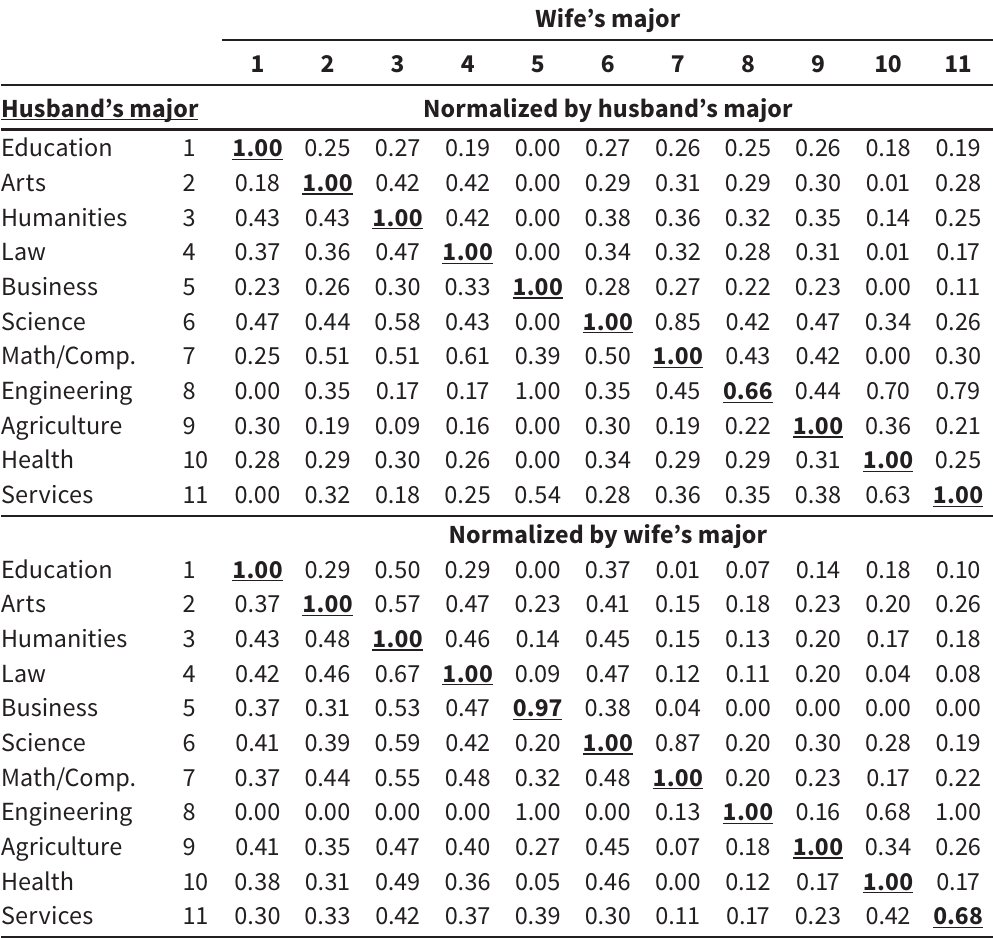
Field-of-study homogamy (FSH) by prime CIP codes (weighted) Wife’s major Normalized by husband’s